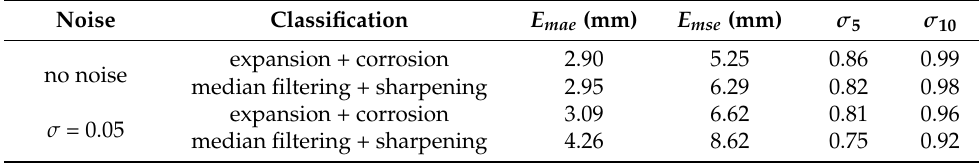
Table 2. Error indicators (dilation and erosion).